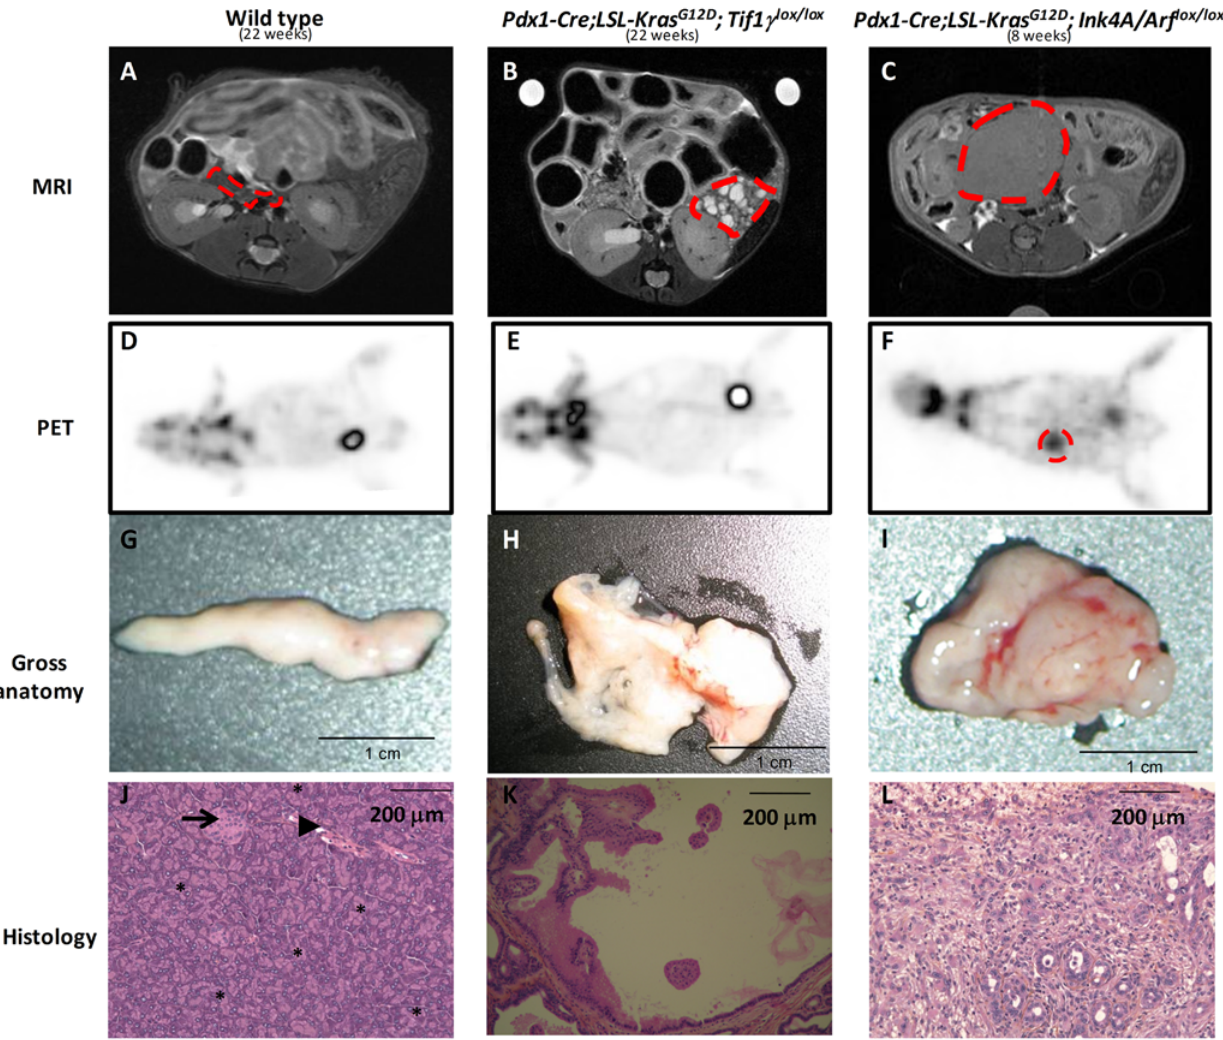
Figure 1. Homozygous deletion of Tif1 c cooperates with activated Kras G12D mutation to induce cystic tumors of the pancreas. Magnetic Resonance Imaging (MRI) (A–C). Positron Emission Tomography (PET) (D–F). Gross anatomy of the pancreas after dissection (G–I). Hematoxylin Phloxine Saffron (HPS) staining of pancreas sections (J–L). Acinar tissue (stars), scattered endocrine islets (arrow) and exocrine ducts (arrowhead). When notified, pancreas is circled in red dashed lines. Pdx1-Cre;LSL-Kras G12D ;Tif1 c lox/lox used in this experiment was 154 days old and representative of the 4 mice we analyzed at the age of 18–27 weeks. doi:10.1371/journal.pgen.1000575.g001 (Figure 1F). Macroscopic analysis of the Pdx1-Cre;LSL-Kras G12D ; Tif1 c lox/lox pancreas confirmed the presence of numerous cysts affecting the entire organ without macroscopic evidence of